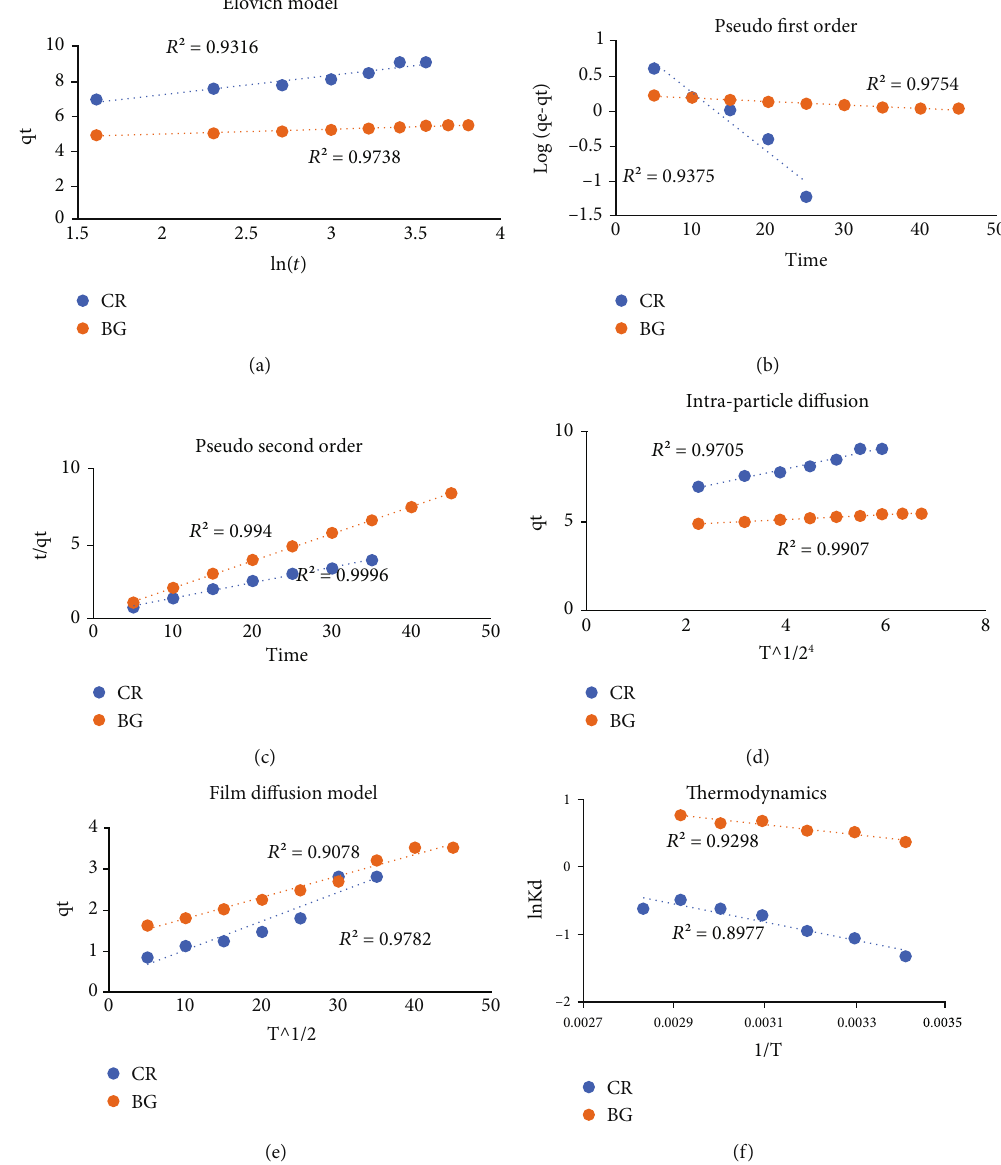
Figure 7: Comparative kinetic and thermodynamic studies plots for CR and BG dye removal by BO. (a) Elovich plot, (b) pseudo fi rst order, (c) pseudosecond order, (d) intraparticle di ff usion model, (e) fi lm di ff usion model, and (f) thermodynamic parameters of CR and BG